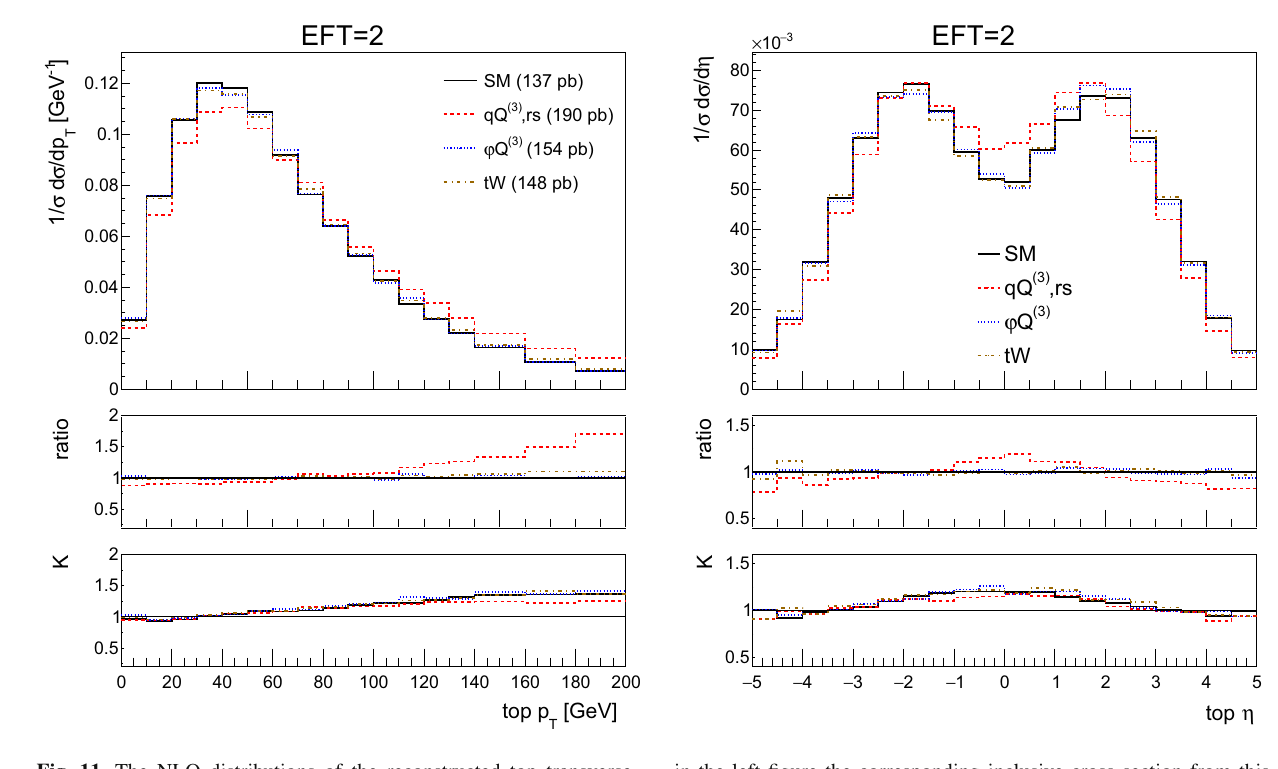
Thevectors (cid:10) p j and (cid:10) p q